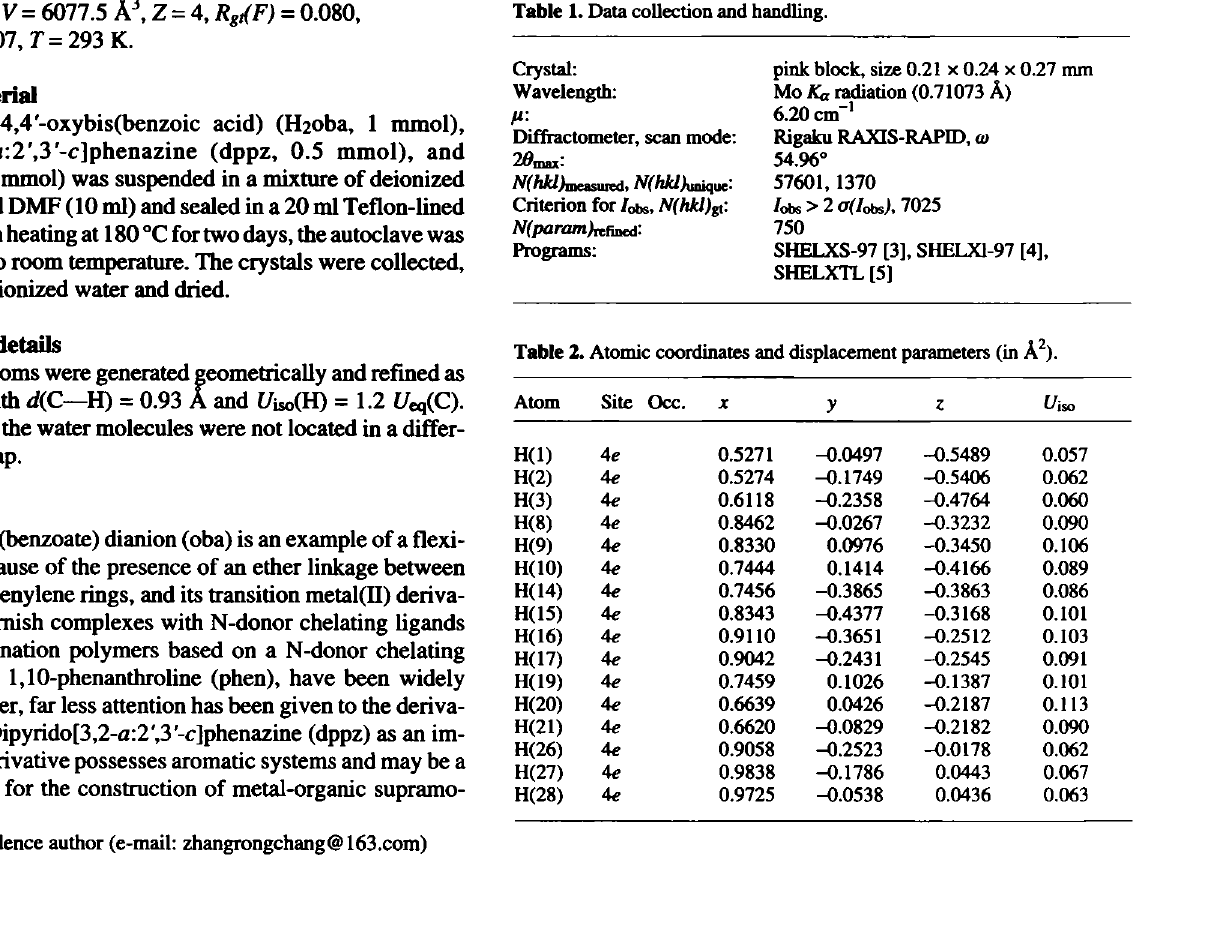
Table 1. Data collection and handling.